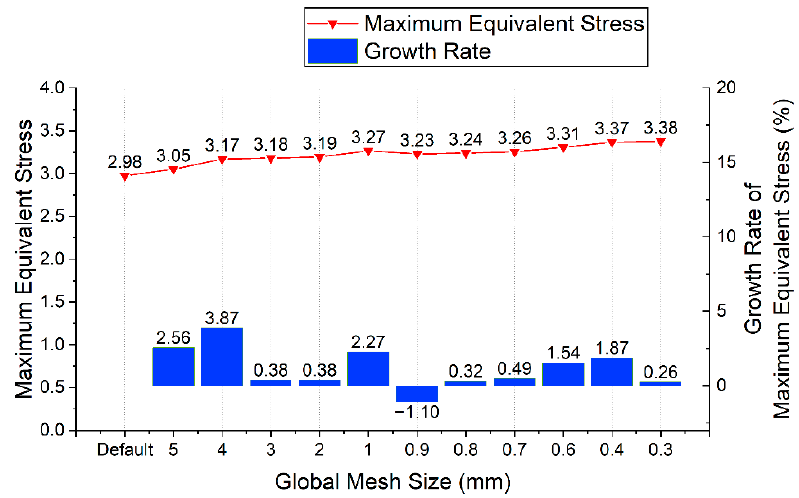
Figure 16. Maximum equivalent stress of all results from static analysis.